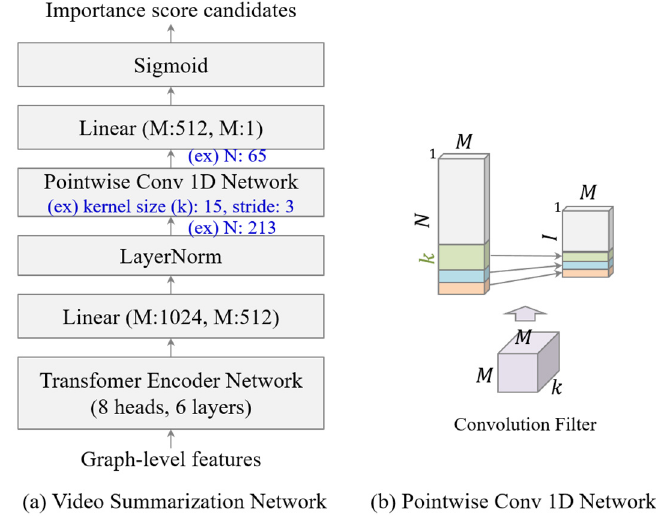
Figure 4. The overall architecture of our network.